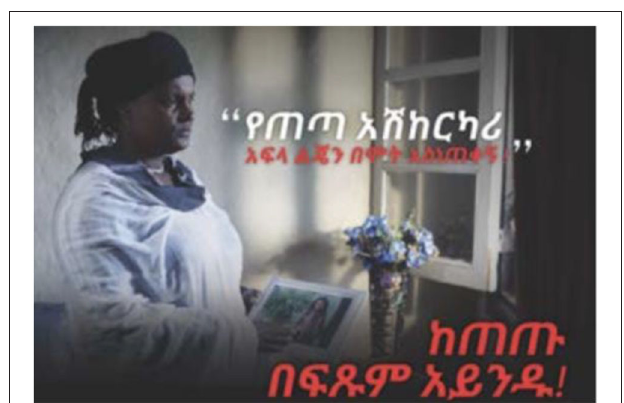
FIGURE 2 | Image from PSA